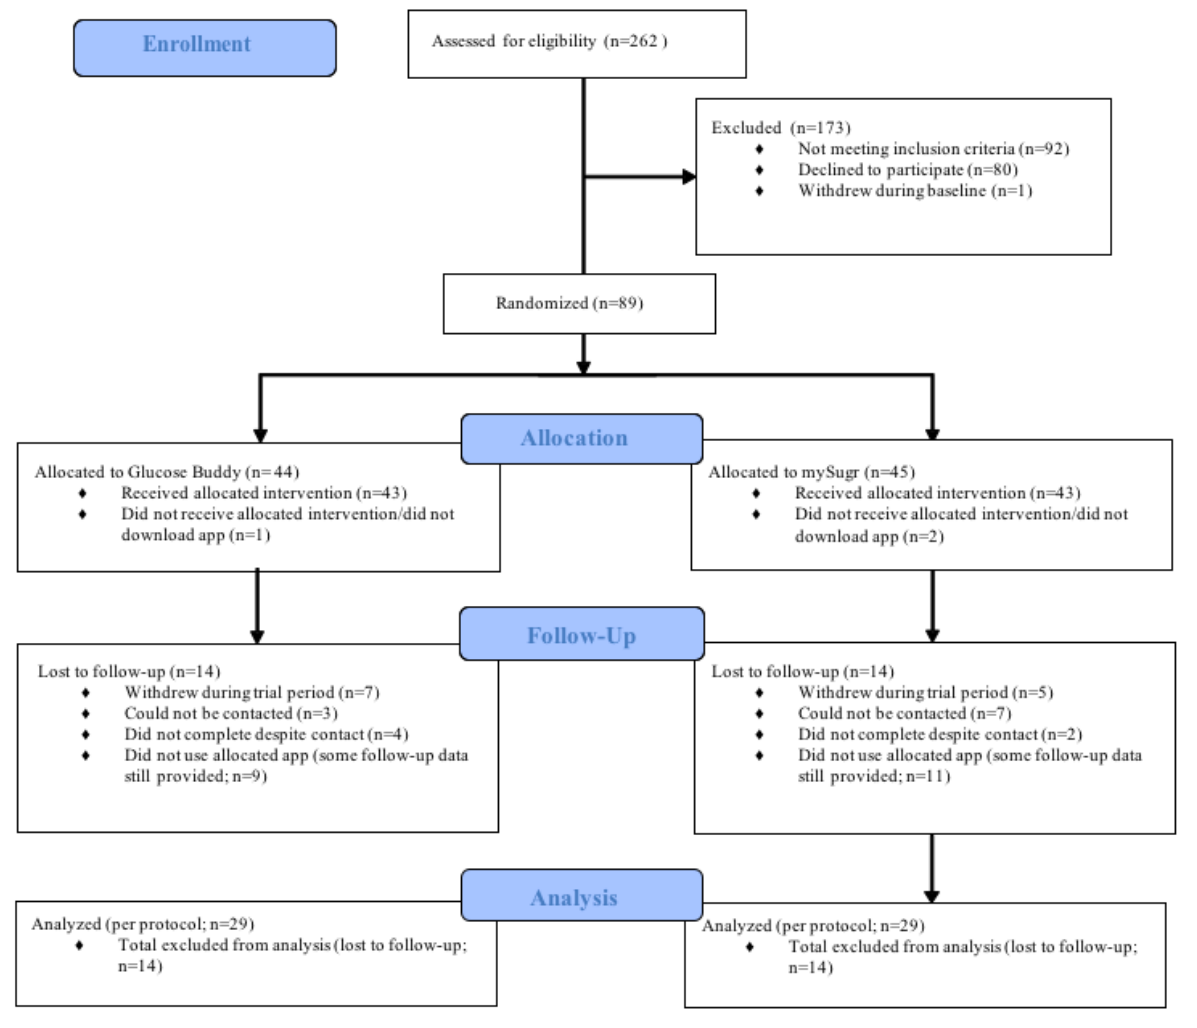
Figure 1. Consolidated Standards of Reporting Trials (CONSORT) diagram of participant